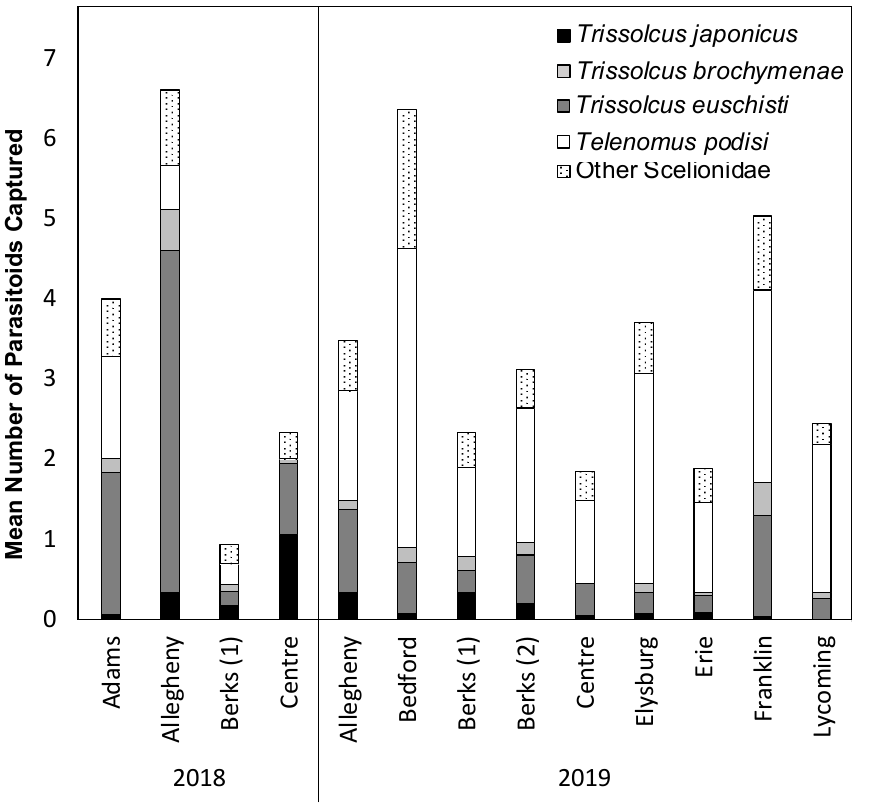
Figure 1. Mean number of Trissolcus japonicus and other known scelionid egg parasitoids captured in across the entire season and all orchards sampled during the 2018 and 2019